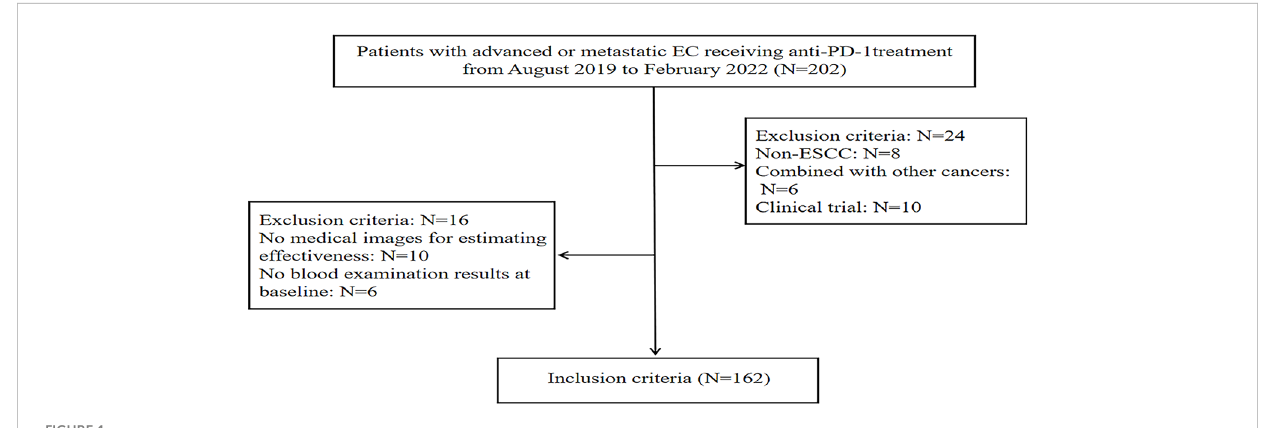
FIGURE 1 The fl owchart of the patient selection